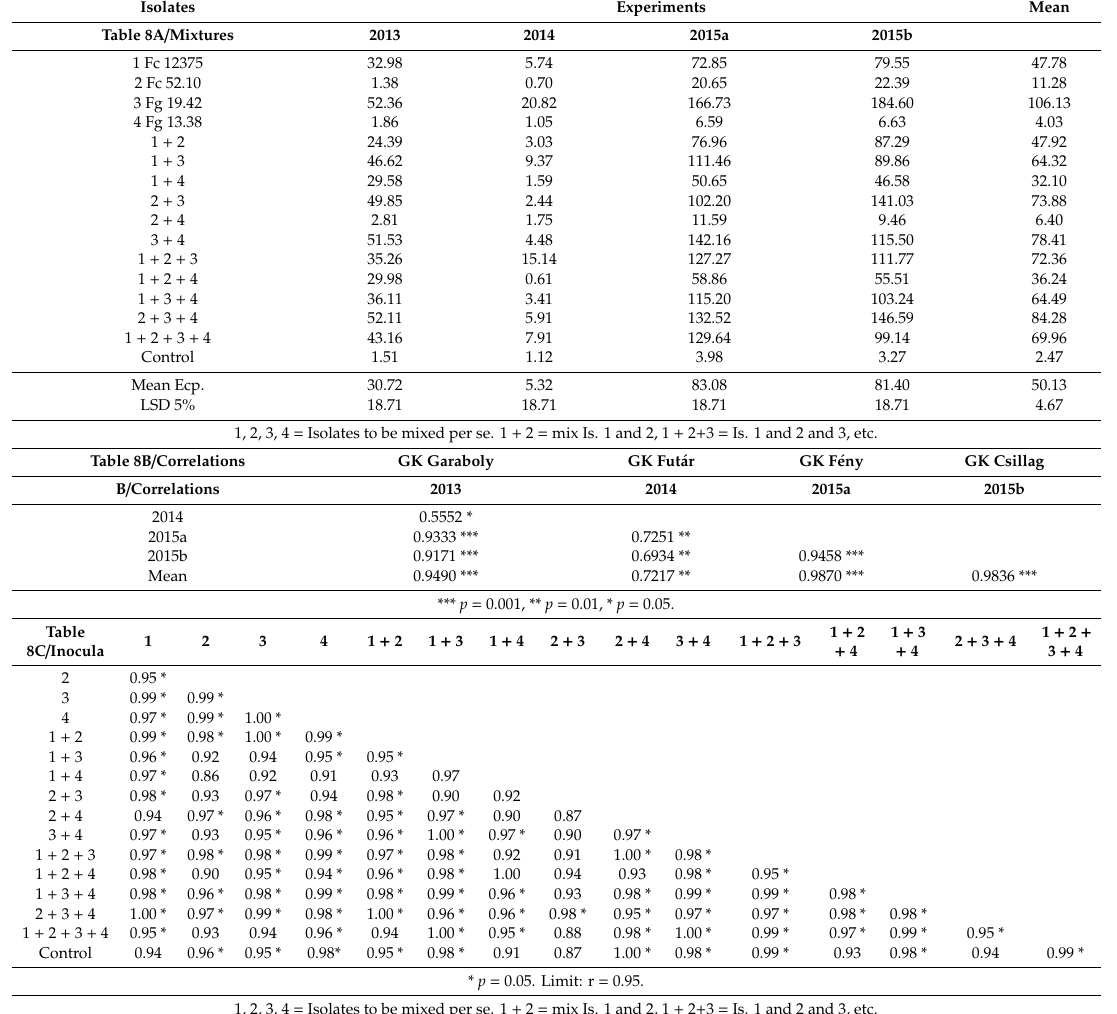
Table 8. Response of wheat to the di ff erent isolates and their mixtures. DON data (mg / kg) of the experiments across wheat cultivars, Szeged, 2013–2015. Isolates Experiments Mean Table 8A / Mixtures